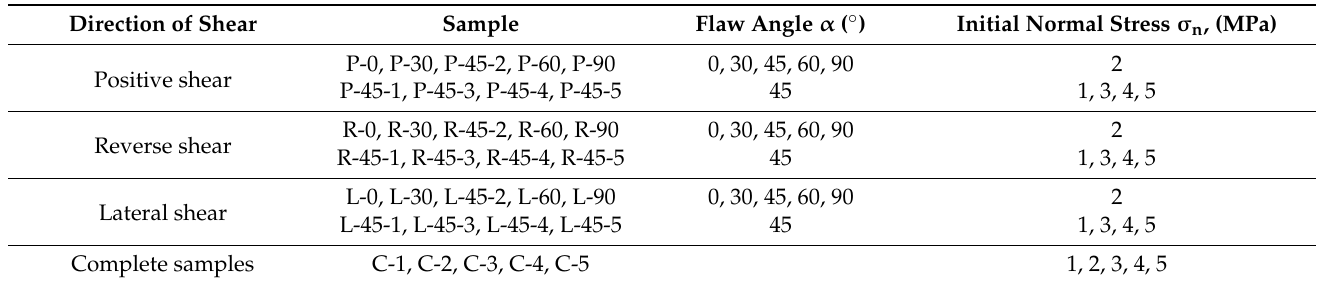
Table 2. Rock-like sample numbers and test